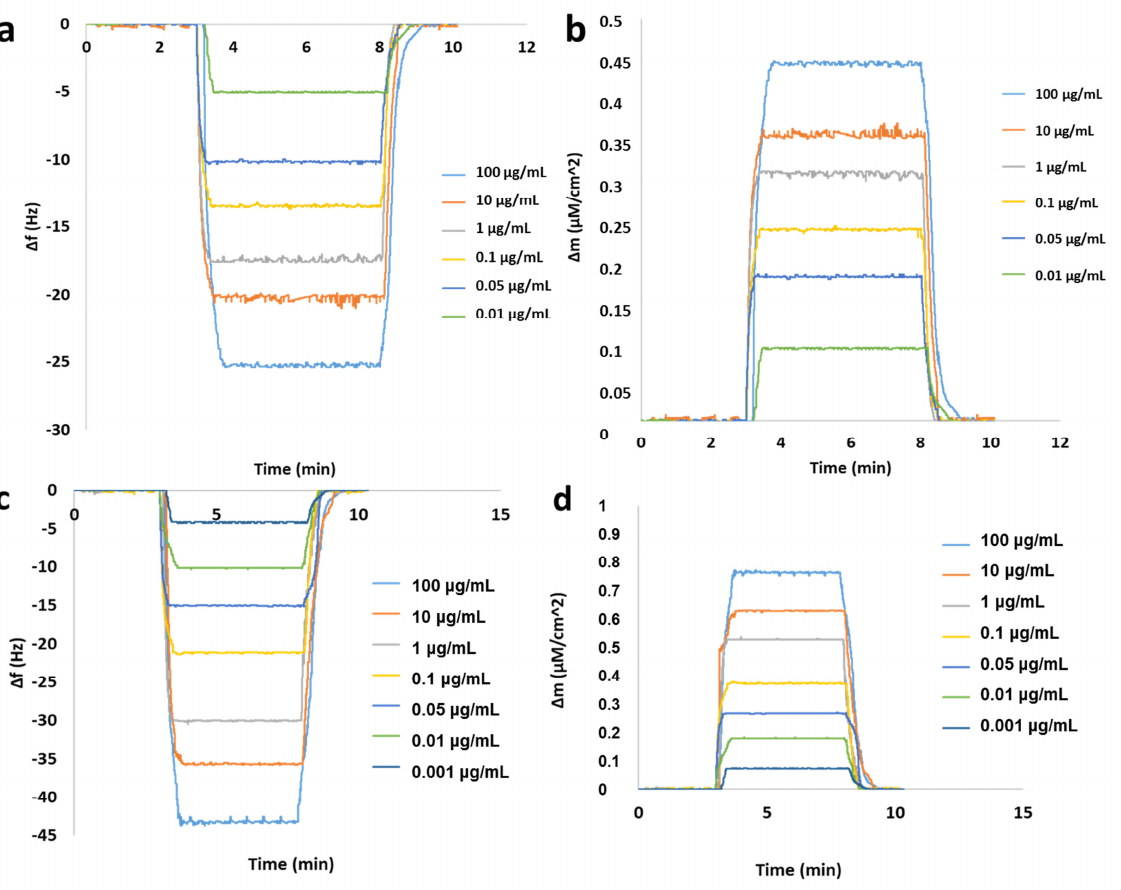
Figure 6. QCM sensor time versus oscillation frequency ( a ); mass changes ( b ) for Cu(II)-MIP1 time versus oscillation frequency ( c ); and mass changes ( d ) for Cu(II)-MIP2 QCM nanosensor. The ∆ m value of the Cu(II)-MIP1 and MIP2 QCM nanosensors increased as the con- centration of Cu(II) ions increased. The ∆ m value of the Cu(II)-MIP1 QCM nanosensor reached about 15 µ M, and the ∆ m value of the Cu(II)-MIP2 QCM nanosensor reached equilibrium at approximately 78 µ M (Figure 7). At the end of five repeated rebinding cycles of the Cu(II)-MIP QCM nanosensor, no significant decrease in the binding capacity of Cu(II) was observed. This result shows that the Cu(II)-MIP QCM nanosensors could be used repeatedly while maintaining the Cu(II) binding capacity.